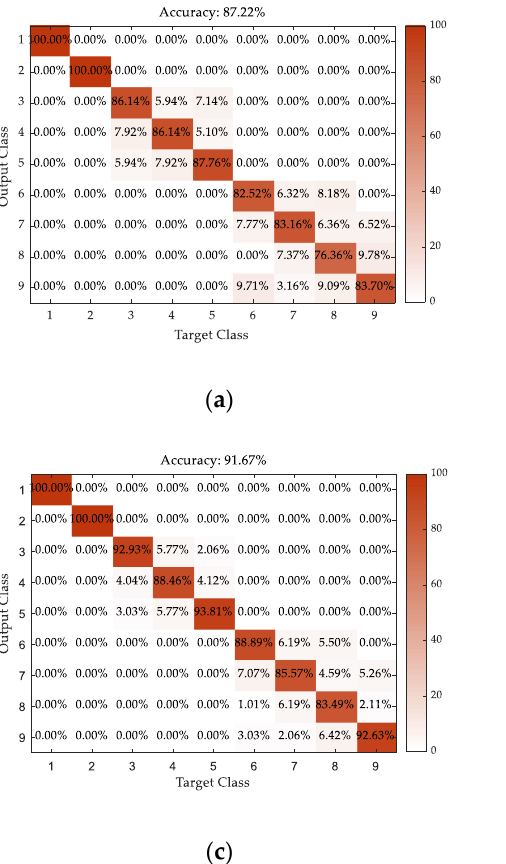
Figure 10. Confusion matrices for four classifiers: ( a ) KNN; ( b ) SVM; ( c ) ELM; ( d ) sound pressure level conversion.